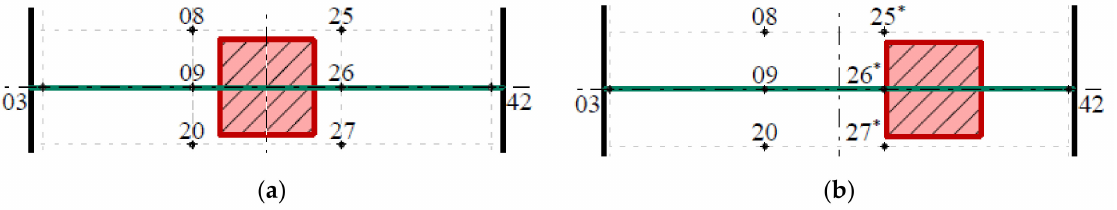
Figure 16. Longitudinal sections: ( a ) centrically loaded slab G10; ( b ) eccentrically loaded slab G11. The maximum negative deformations in the slabs of track sensors 03–42, which correspond to the lifted corners of the slabs, were 13.06 mm (centrically loaded slab G10, sensor 42) and 20.37 mm (eccentrically loaded slab G11, sensor 03), respectively. The maximum positive deformations in the slabs of track sensors 03–42, which correspond to the pushing of the slabs into the subsoil, were 26.72 mm (centrically loaded slab G10, sensor 09) and 21.84 mm (eccentrically loaded slab G11, sensor 26 *), respectively. Comparative